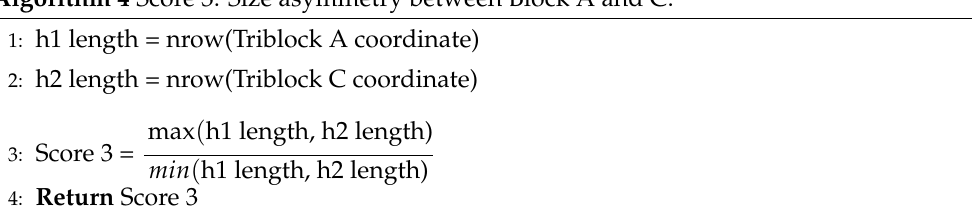
Figure 14. Size asymmetry between Block A and Block C (Score 3). The number of groups belonging to Blocks A and Block C can be compared. Algorithm 4 Score 3: Size asymmetry between Block A and